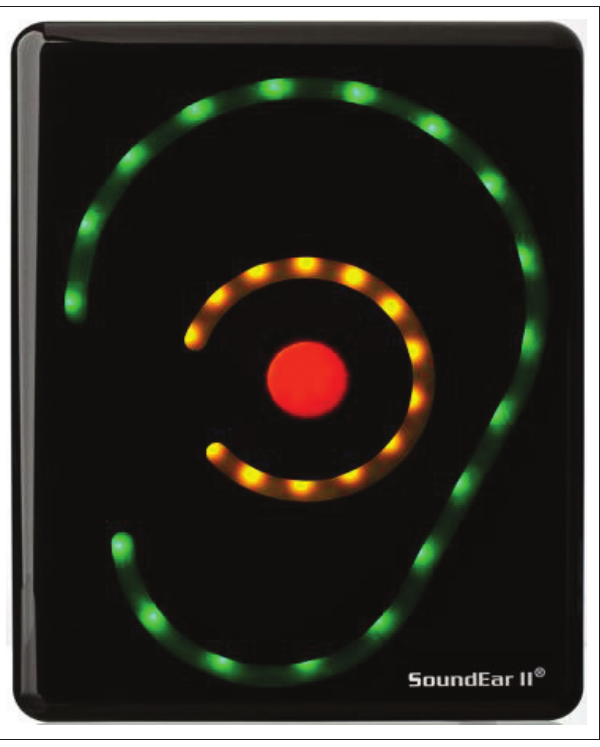
FIGURE 1: SoundEar II device with all three LED strip displays lit up. The display lights up individually according to the noise level. Green indicates that the device is on and at an acceptable noise level, yellow indicates that noise levels are approaching the pre-set noise limit and red indicates that the noise level exceeded the pre-set noise